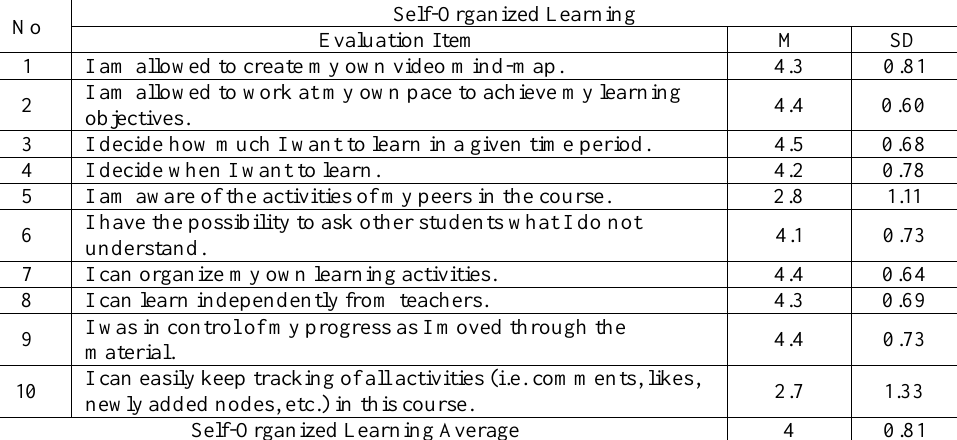
Descriptive Results of Self-Organized Learning (N=50) Self-Organized Learning No Evaluation Item